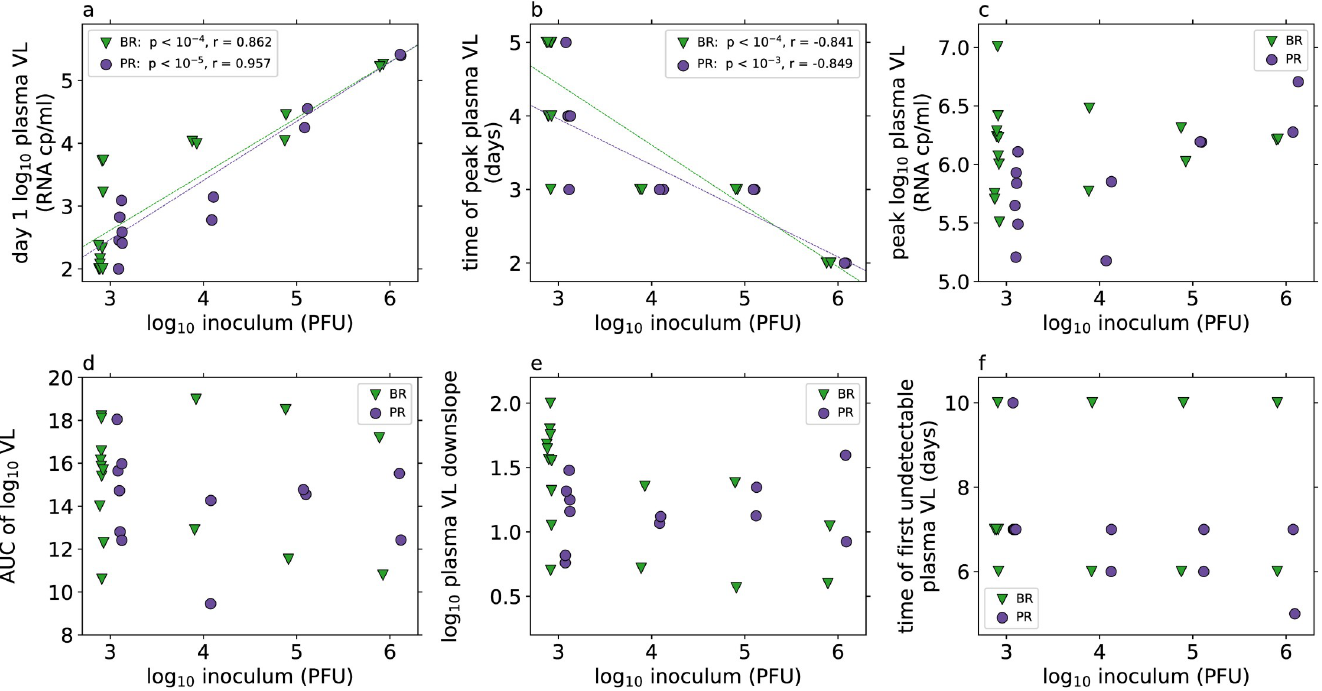
Fig 2. Viral load (VL) characteristics (from measured data, Fig 1) by inoculum dose (log 10 PFU, x-axis) and viral strain (indicated by markers, BR: green triangles, PR: purple circles). Correlations between inoculum dose and VL characteristics are tested by Pearson correlation for each strain separately, and where this is found to be significant at the α = 0.05 level after Bonferroni correction for multiple testing ( m = 6) the linear regression line is shown in the panel, and the p -value and correlation coefficient are shown in the legend. Differences in VL characteristics between viral strains for each inoculum group are tested with the Mann-Whitney U test, and none are found to be significant at the α = 0.05 level after Bonferroni correction for multiple testing ( m = 6). The day 1 VL, time of peak VL and value of peak VL are the observed measurements. The area under the curve (AUC) of the log 10 plasma VL and the downslope of the log 10 plasma VL are calculated as described in the methods. Animals with VL data only to day 7 or which do not have any undetectable VLs after the peak are excluded from the analysis of “time of first undetectable plasma